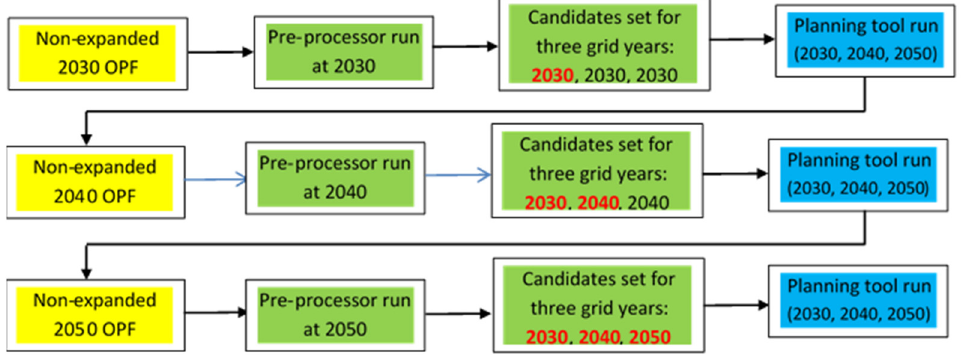
Figure 5. Interaction between planning tool and pre-processor.